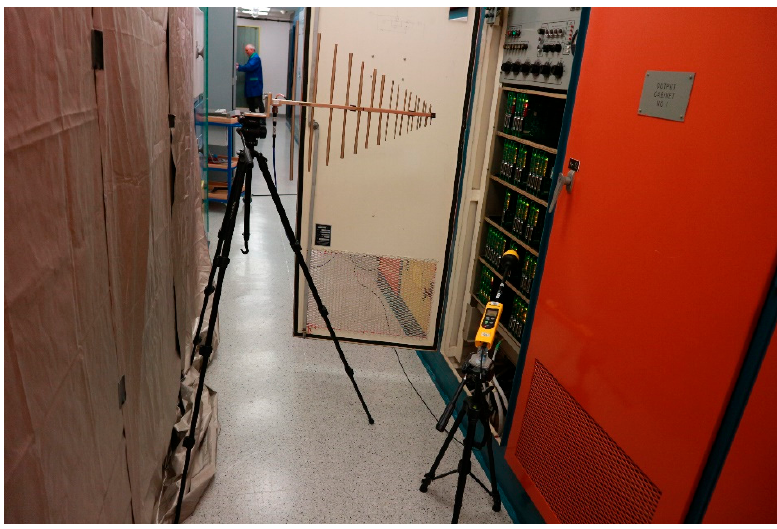
Figure 3. Immunity test of a protection system cabinet in the main control room.